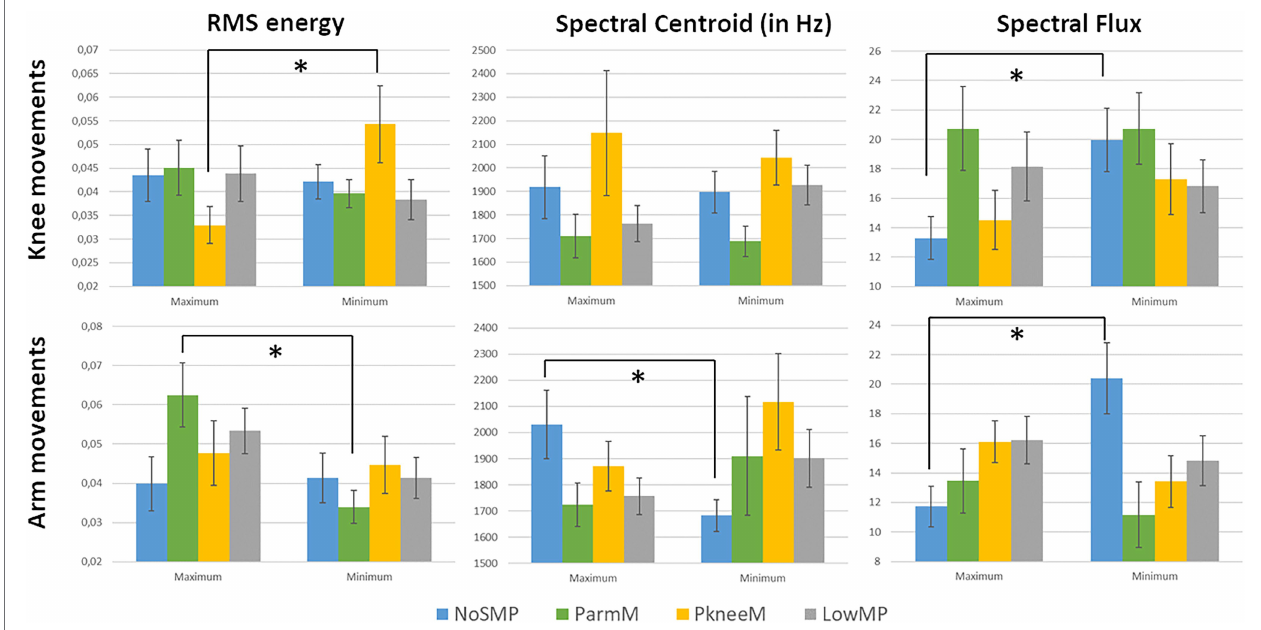
FIGURE 6 | Mean values of the RMS energy, the spectral centroid and the spectral flux by motion type (Abbreviations of the motion types see Figure 1 ) and movement peaks (maximum: high angular peaks; minimum: low angular peaks; error bar: standard error of the mean; * p < 0.05).